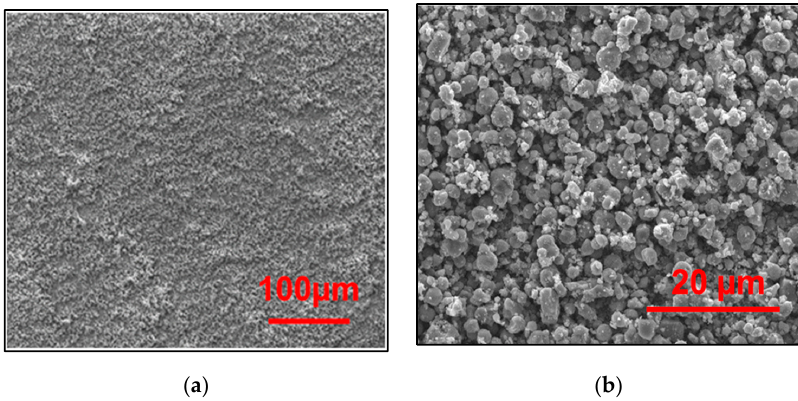
Figure 10. SEM images of the TiO 2 / CL at optimum operating conditions: ( a ) Scale of 100 µm, and ( b ) Scale of 20 µm.